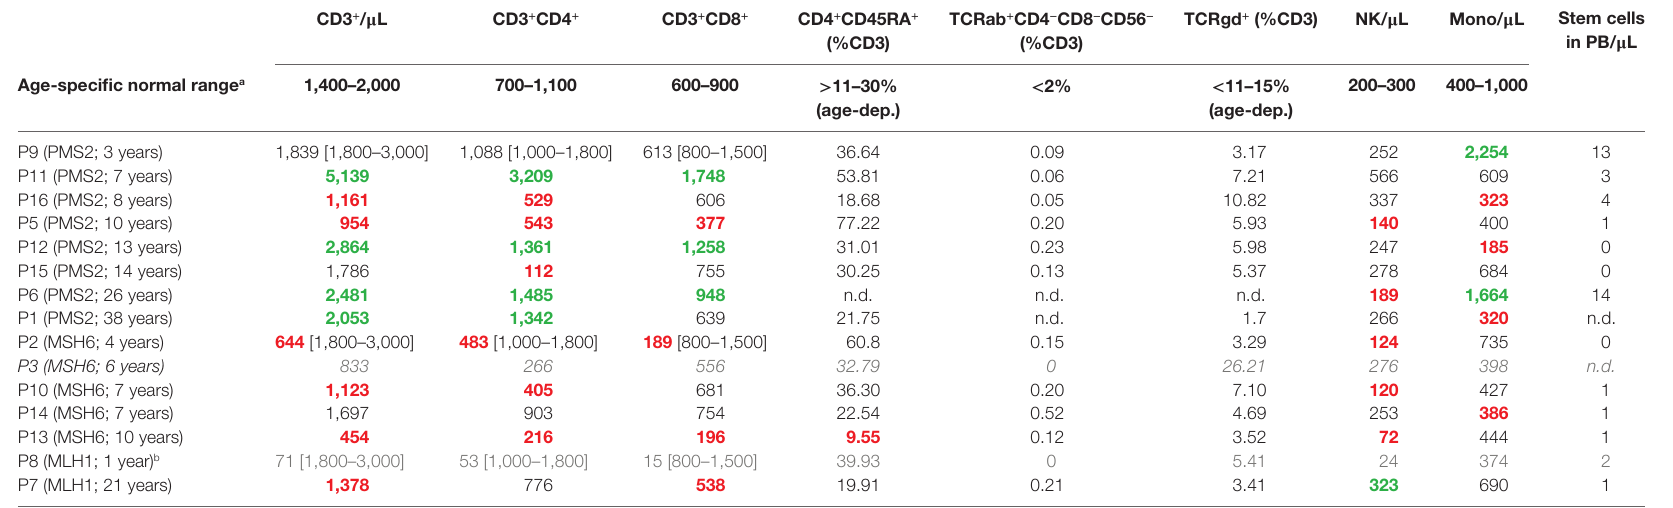
Samples are sorted according to gene defect and age. a Except otherwise stated [square